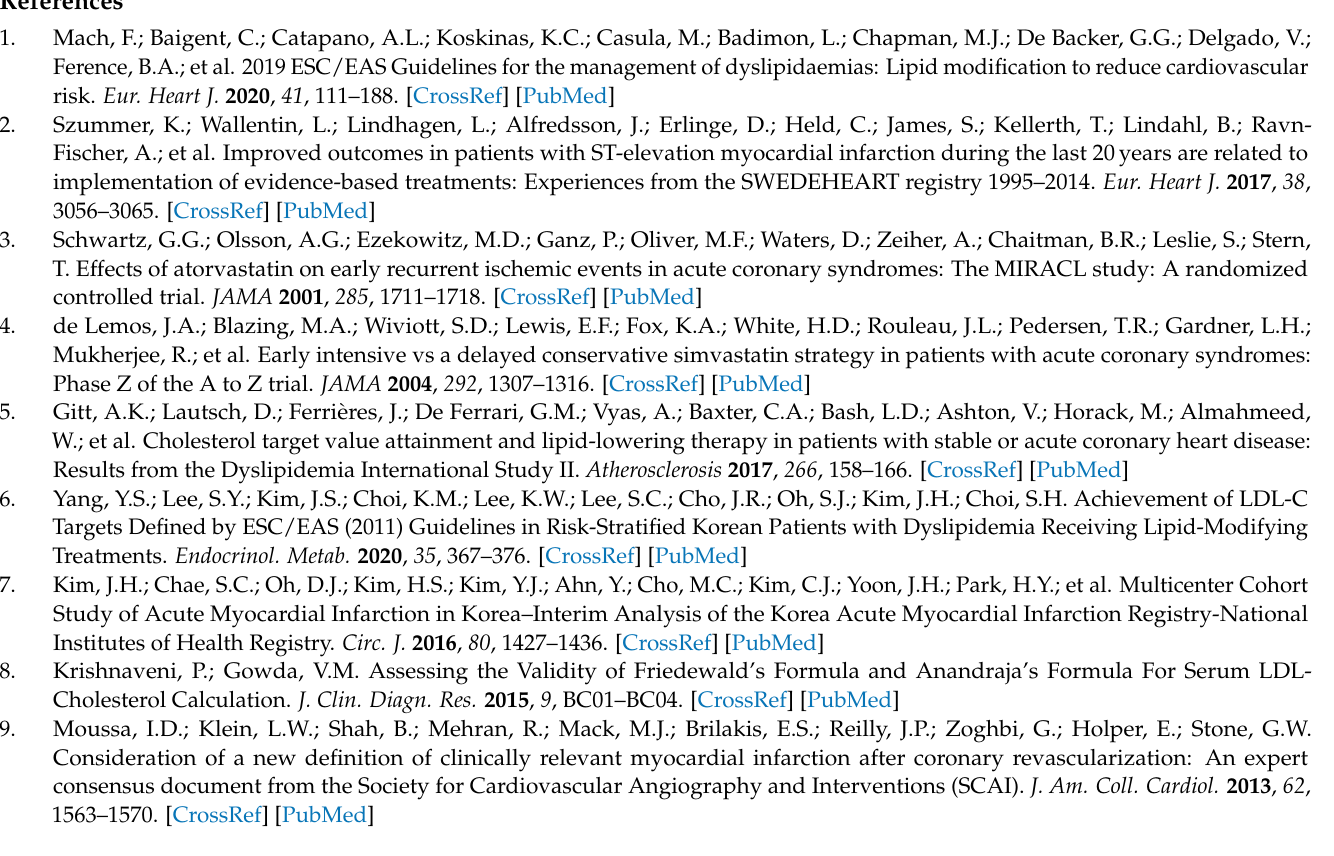
with the risk of MACCE. Median and interquartile range are presented as dotted lines. (B) Spline curve for the association of follow-up LDL-C level with the risk of MACCE. Target LDL-C goal of 70 mg/dL is presented as a dotted line; Figure S4: Subgroup analysis of target LDL-C achievement for the primary endpoint; Table S1: Statin intensity classification; Table S2: Statin exposure and LDL-C reduction; Table S3: Patients with ongoing statin therapy and an LDL-C level > 70 mg/dL at the 1-year follow-up visit; Table S4: Crude and adjusted hazard ratios of the primary endpoint; Table S5: Cox’s proportional hazard model analysis of the primary